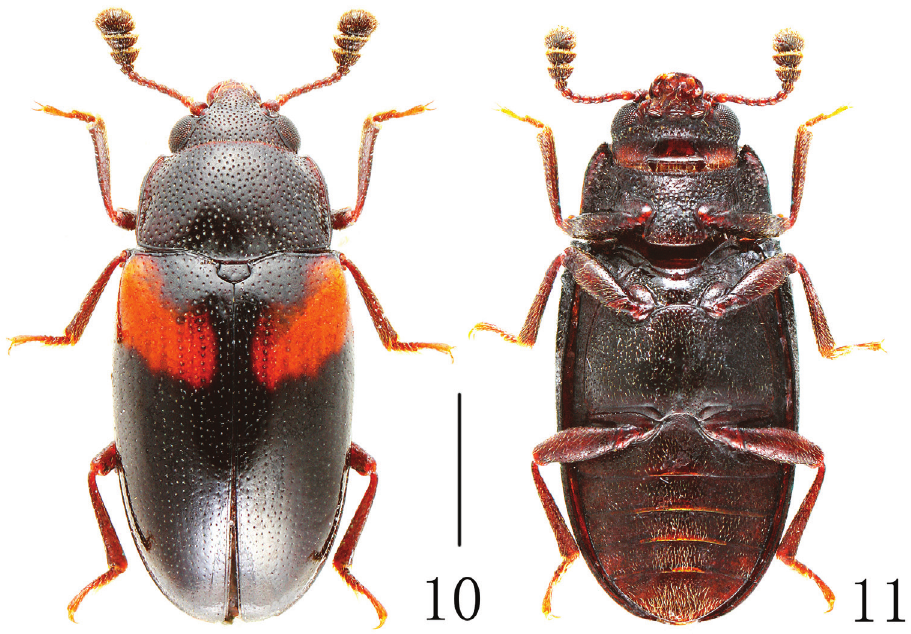
Figures 10–11. Habitus of Dacne ( Xenodacne ) hujiayaoi in dorsal and ventral view. Scale = 1 mm. Description. Body (Fig. 10, 11) stout, elongate, length: 3.6 mm; width: 1.5 mm. Body black; legs, palpi and base of antennae reddish-brown; antennal club dark brown. Each elytron with one orange